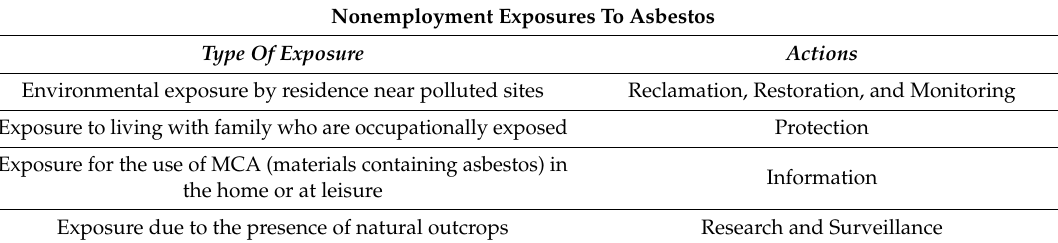
Table 8. Actions to be taken for nonprofessional asbestos